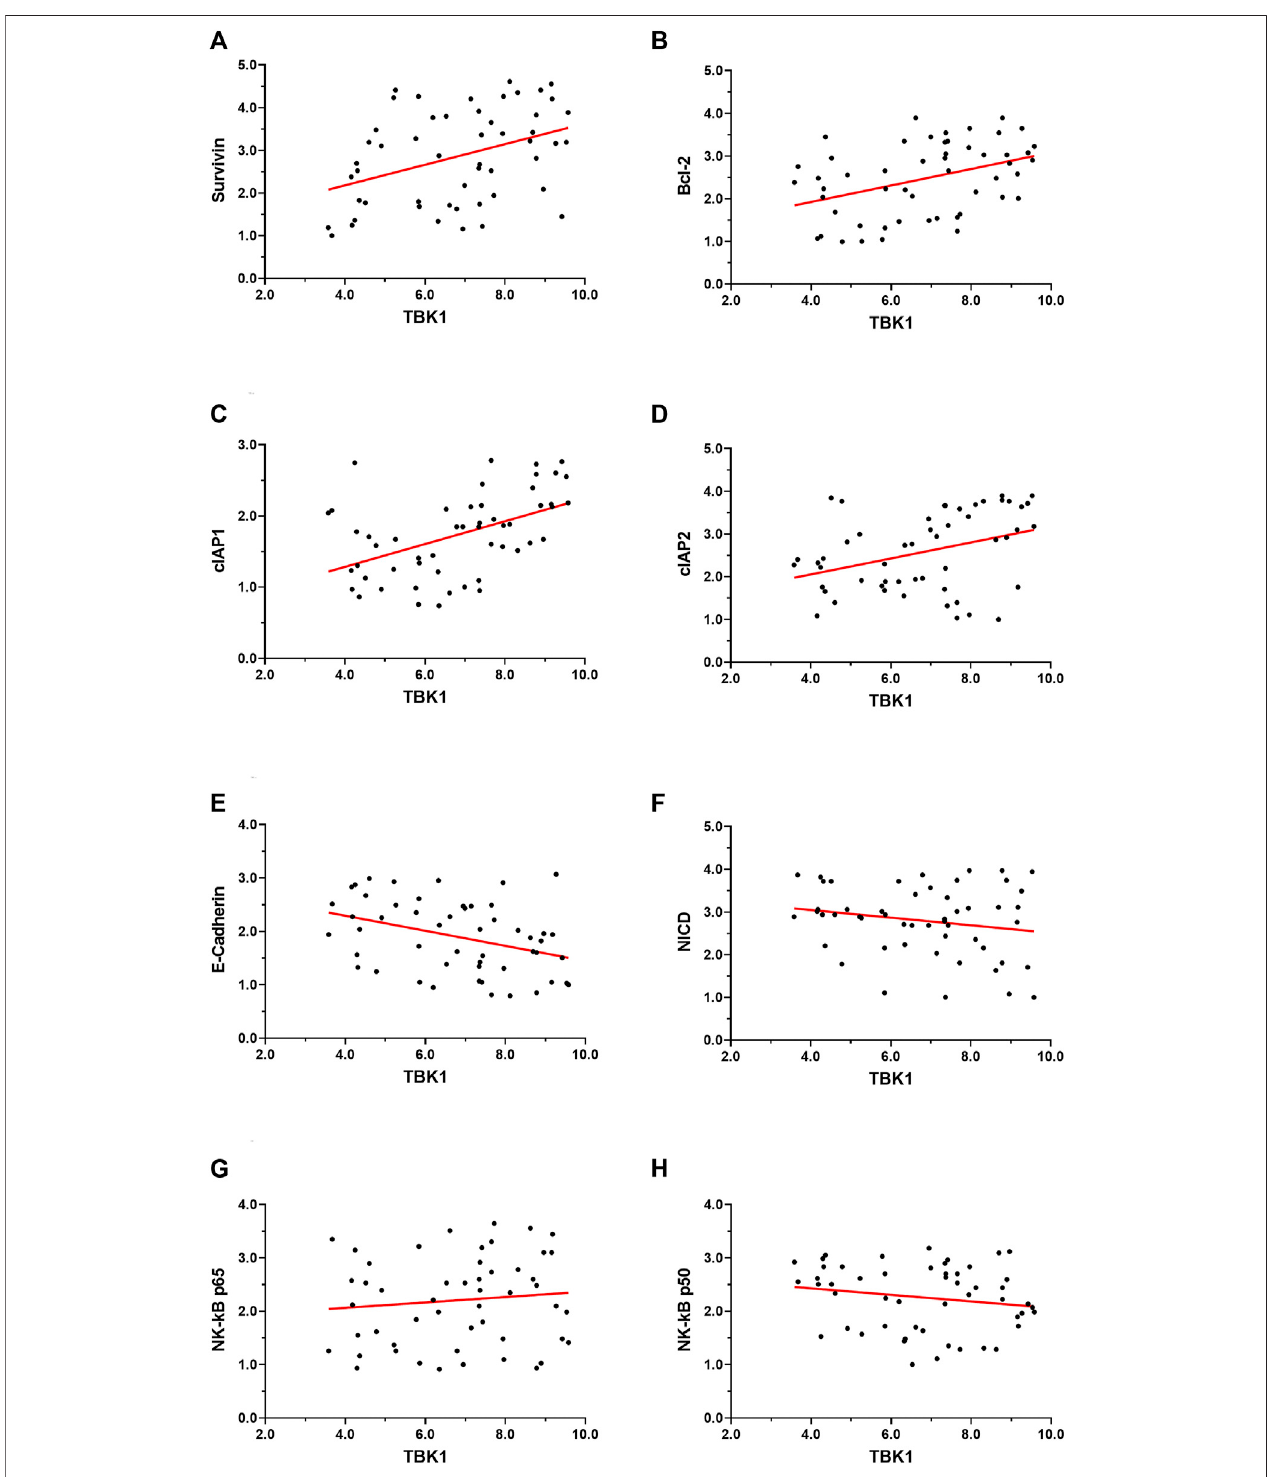
FIGURE4| Therelationshipbetween TBK1 withthedrug-resistance-relatedfactors inHCCspecimens.Theexpression levelof TBK1 anddrug-resistance-related factors in HCC specimens by qPCR. The expression level of TBK1 is on the abscissa, the expression level of each factor is on the ordinate, and the data are shown as a scatter plot. Additionally, a regression equation was fi t to the data (with its p -value) according to the trend of the scatter plot.